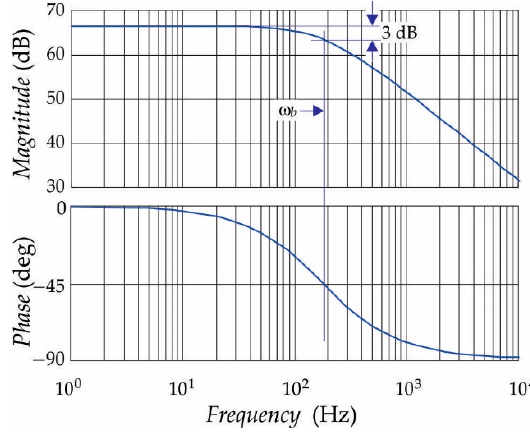
Figure 10. Bode diagram of H o (s).